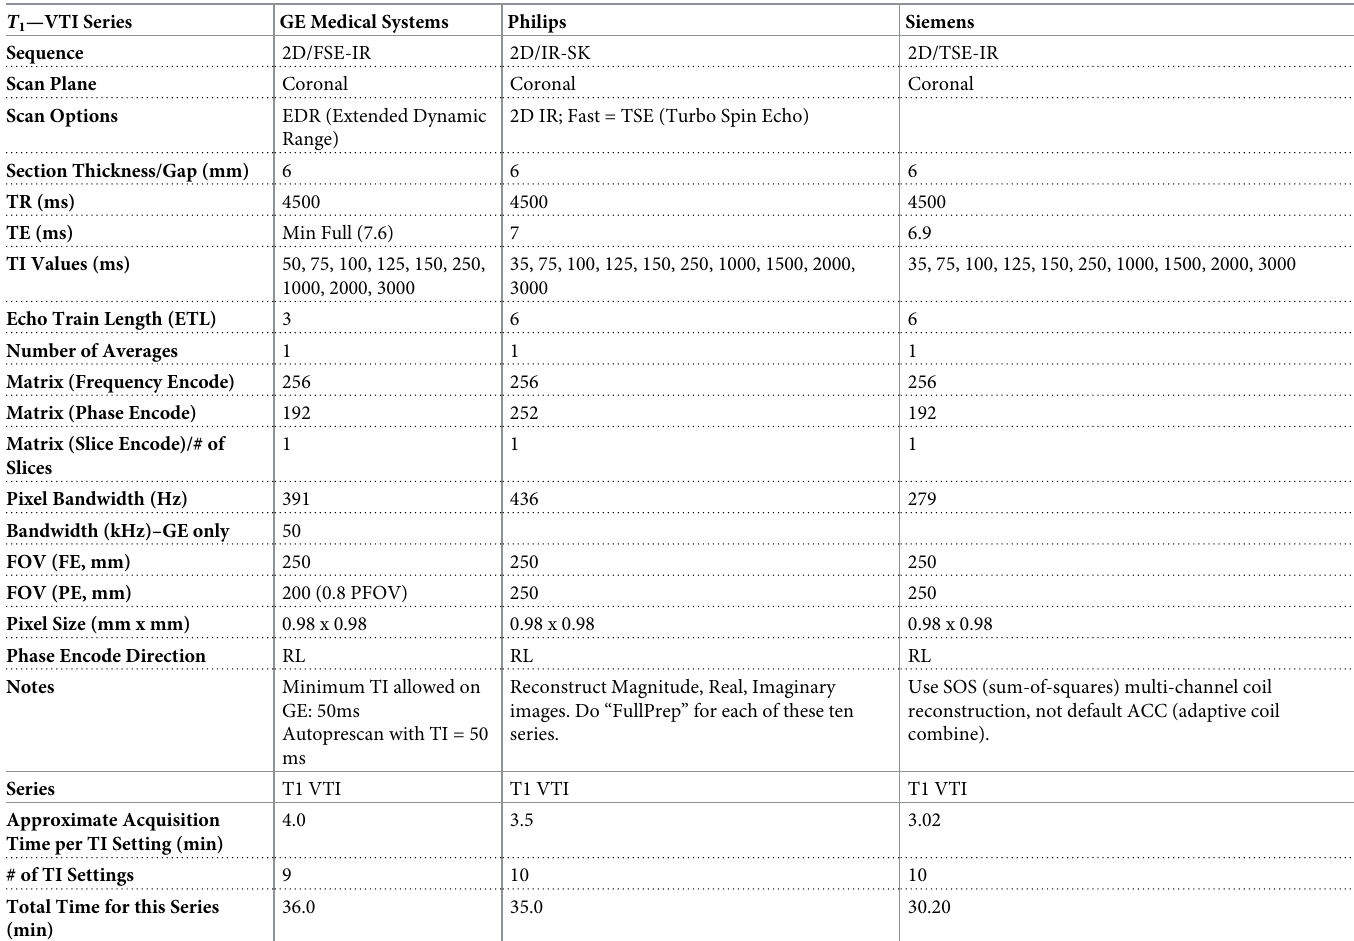
Table 2. Inversion recovery (IR) measurement